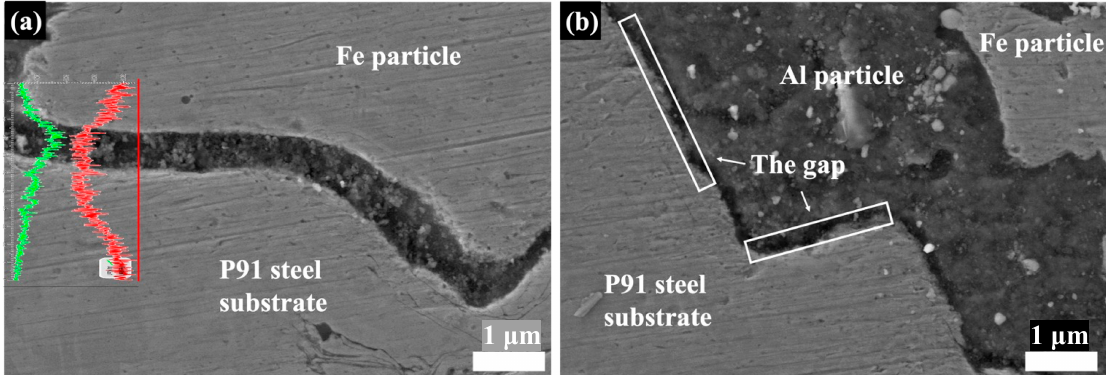
Figure 10. SEM images and EDS line scan analysis of coating/substrate interface of Fe-25Al-P91. ( a ) The green line is the trend curve of Al content and the red line is the trend curve of Fe content. ( b ) shows the enlarged images of the gap.